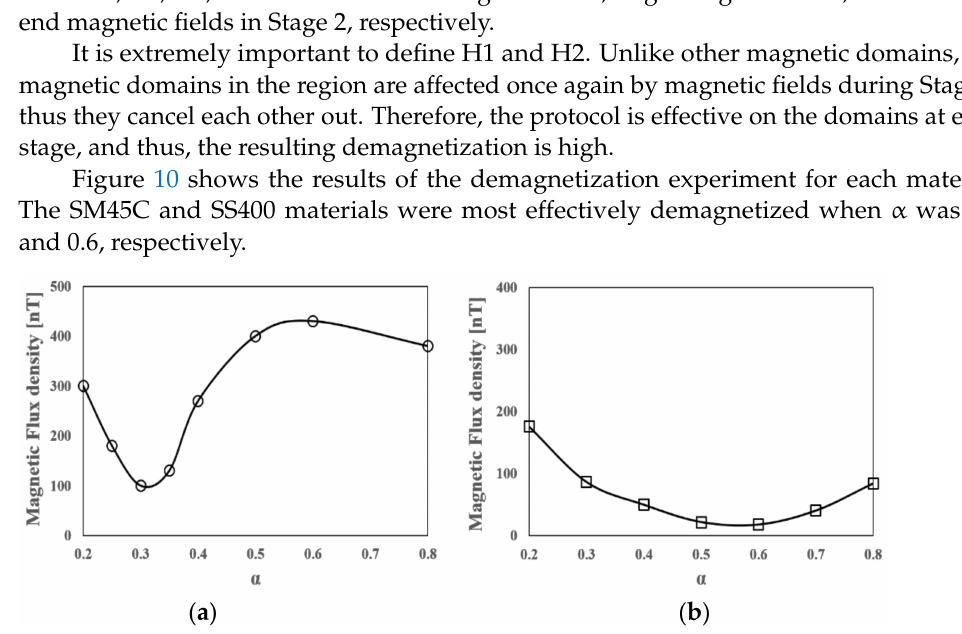
Figure 10. Results of demagnetization experiment according to α : ( a ) SM45C and ( b ) SS400.